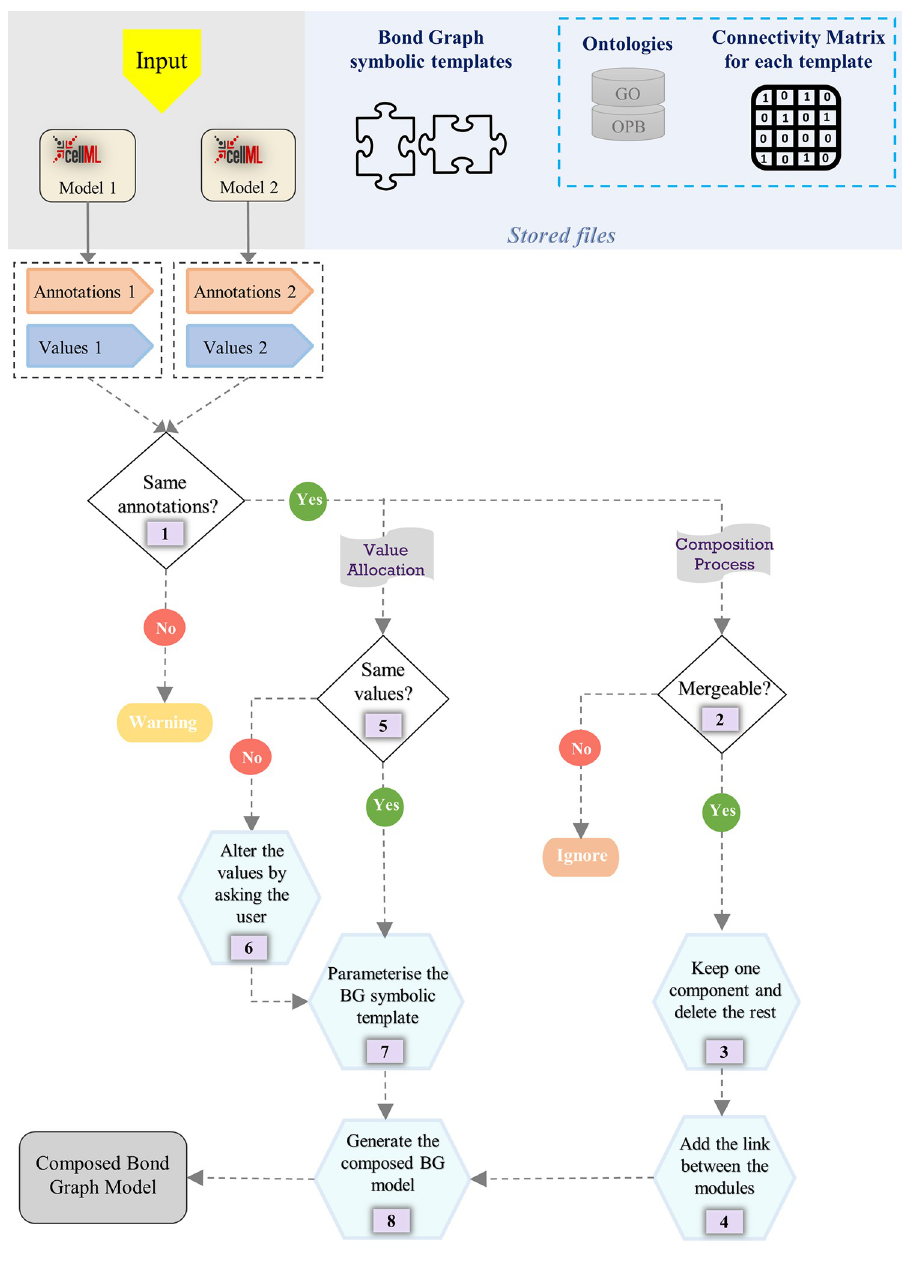
Fig 7. The generic flowchart of our automated model composition approach. The Stored files section shows the saved files for the current model composition framework. Ontologies and connectivity matrices in the blue dashed box are optional in the generic approach but were used in the current framework. The Input section shows two arbitrary CellML models to be merged using our framework but can be extended to any number of models. The main steps of the framework are denoted by numbers